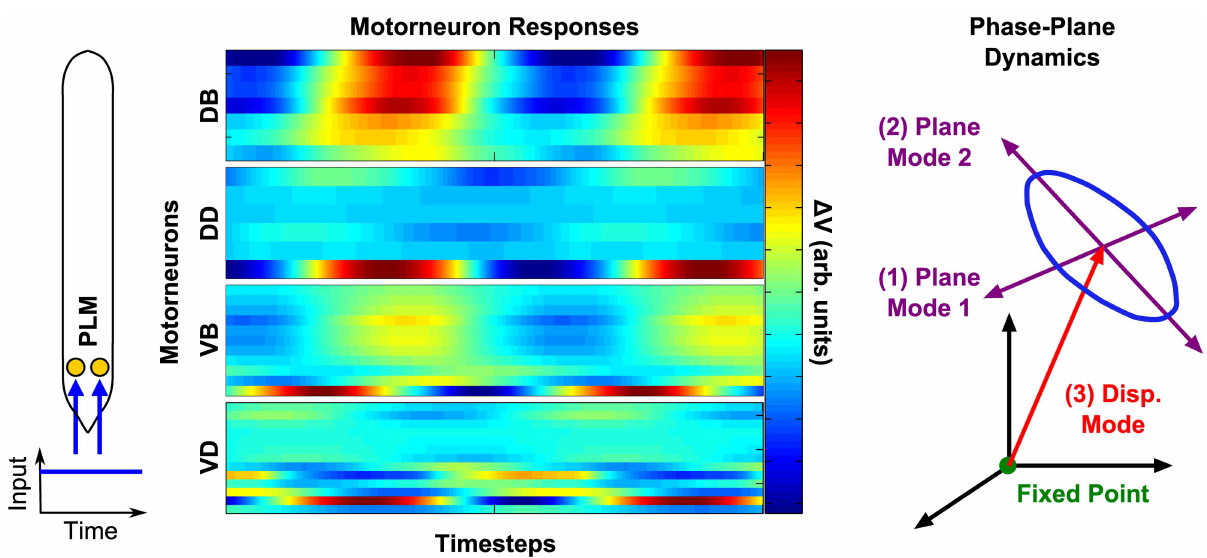
Fig 3. Illustration of the PLM Response as in [11]. Constant stimulationof PLM neurons(corresponding to tail-touch) causes oscillationin body-wallmotorneurons. This oscillationcan be describedas a 2D limit cycle, consistant with the observed2D body shape dynamics of forward motion [29]. The center of this limit cycle is displacedin the full-dimensionalspace from the zero-input fixed point. We refer to the two oscillatorymodes as the “planemodes”, and the displacement from the fixed point to the center of oscillationas the “displacement mode”.